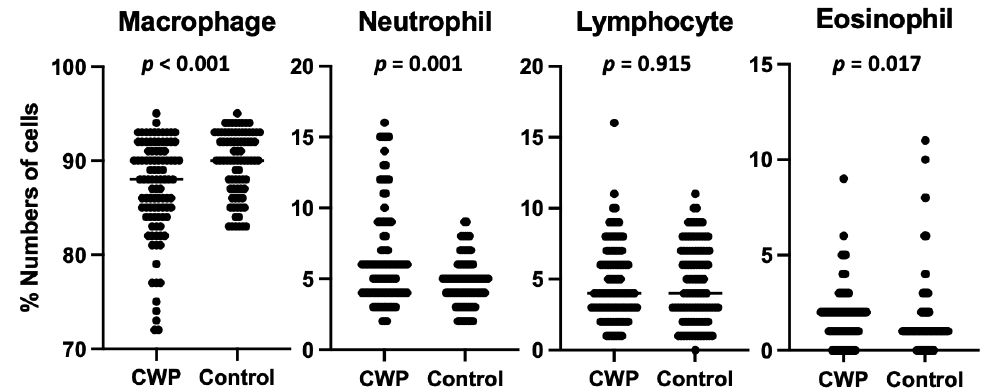
Figure 2. The comparison of bronchoalveolar lavage differential count in coal workers’ pneumoco- niosis and controls. The statistical comparison of the mean of the two groups was performed with the Mann–Whitney test. Abbreviation: CWP, coal workers’